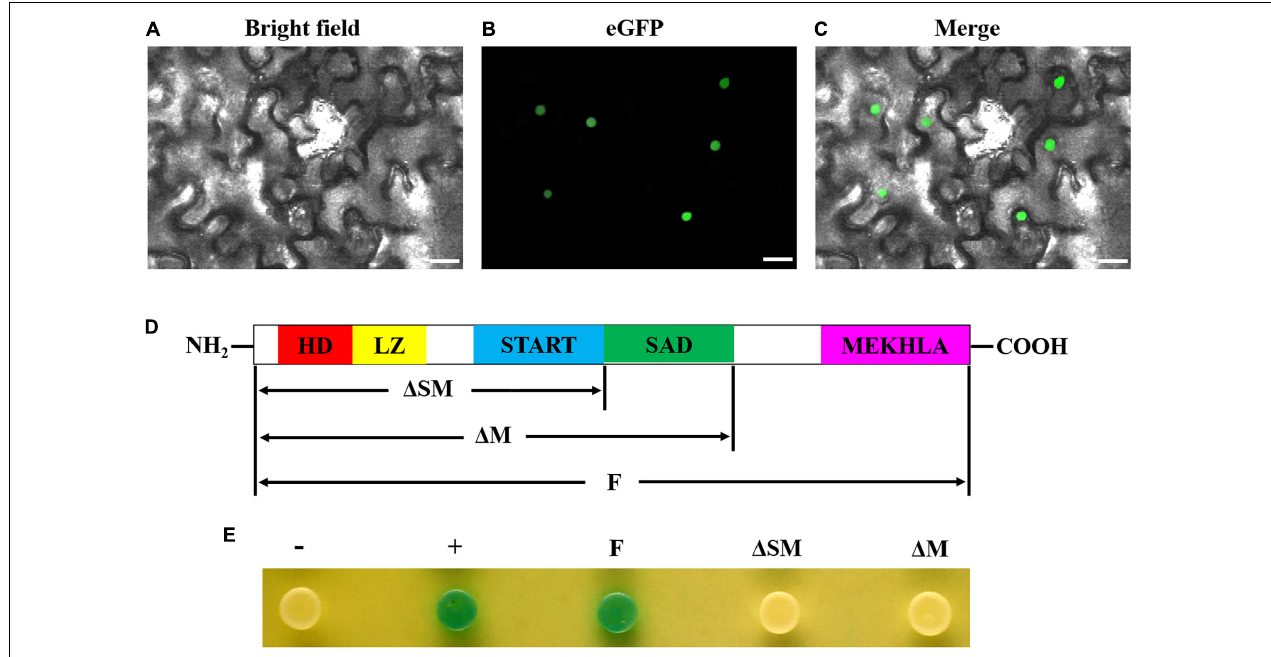
FIGURE 6 | GhHB8-5D is a typical transcriptional activator. (A–C) The subcellular location of GhHB8-5D in epidermal cells of tobacco leaves. Bars = 50 µ m. (D) Schematic diagram shows domain constructs of GhHB8-5D. (E) Assay of GhHB8-5D transcriptional activation activity in yeast. –, negative control; +, positive control; F, full-length of GhHB8-5D; (cid:49) SM, a truncated version of GhHB8-5D lacking SAD and MEKHLA domains; (cid:49) M, a truncated version of GhHB8-5D lacking MEKHLA